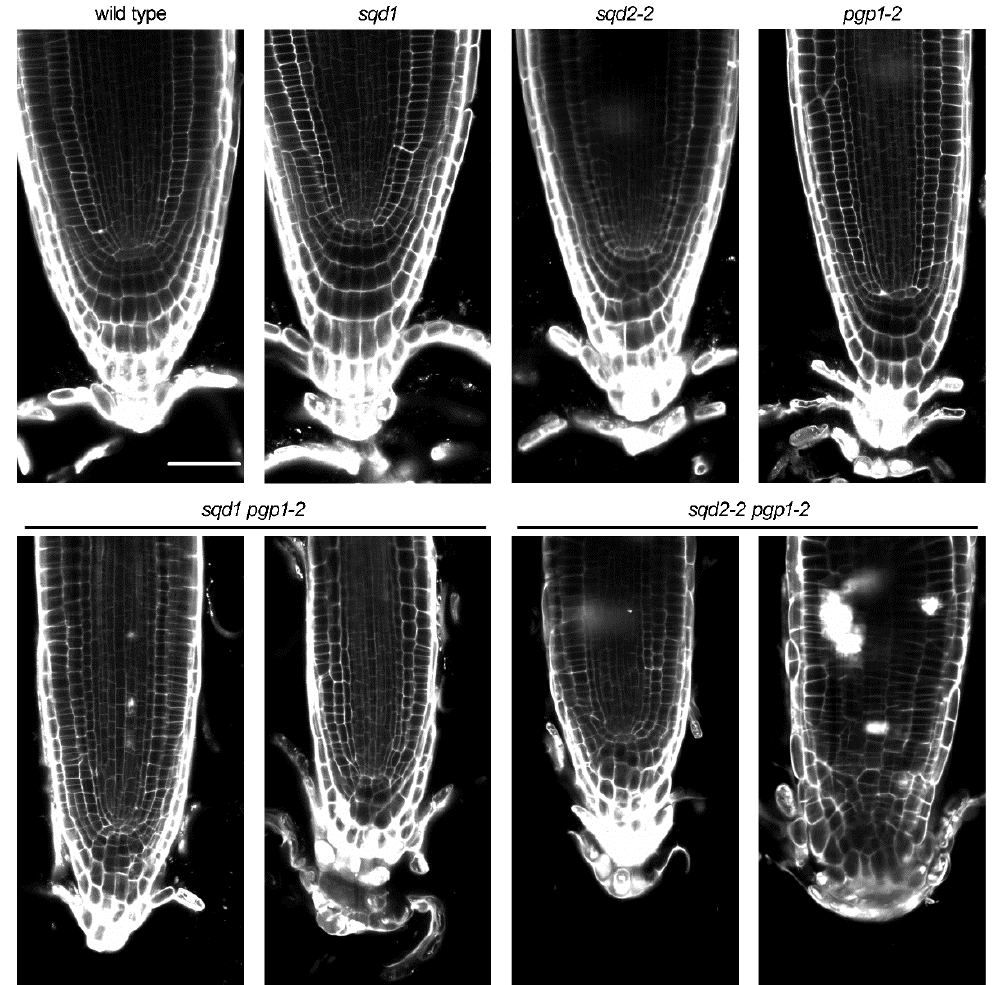
Figure 8. Cellular architecture of root tips of 7-d-old seedlings in wild type and knockout mutants of anionic lipid biosynthesis in plastids. Two different individuals were shown for the sqd1 pgp1-2 and sqd2-2 pgp1-2 double mutants. Scale bar = 50 μm.